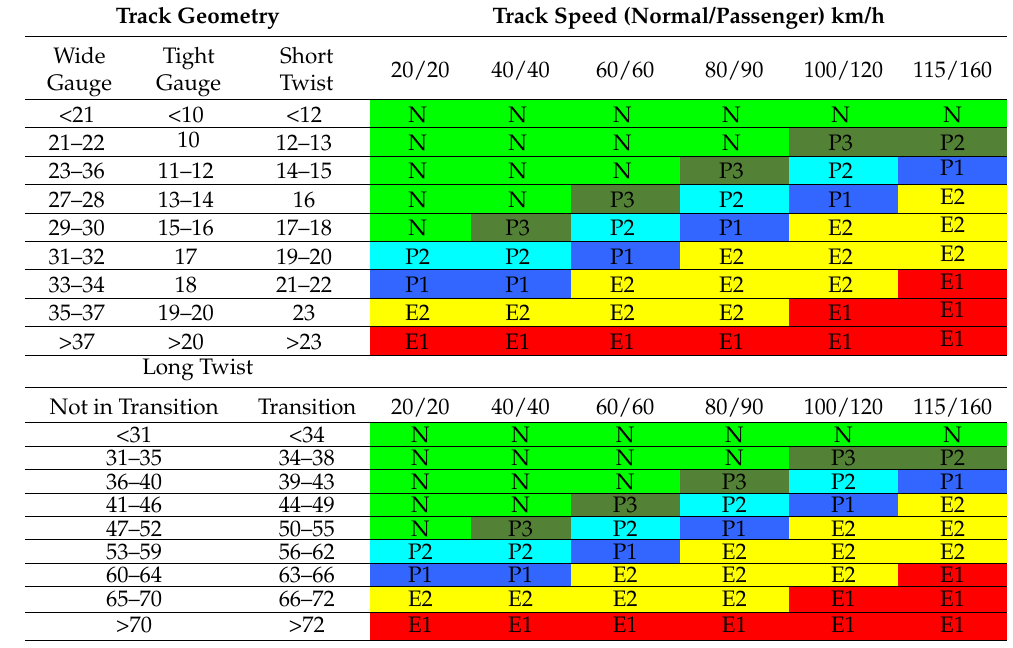
Table 2. Twist limits for ballasted track taken from Australian TMC 203 Track Inspection [55]. Note: N is normal condition, P is priority condition, E is emergency condition.